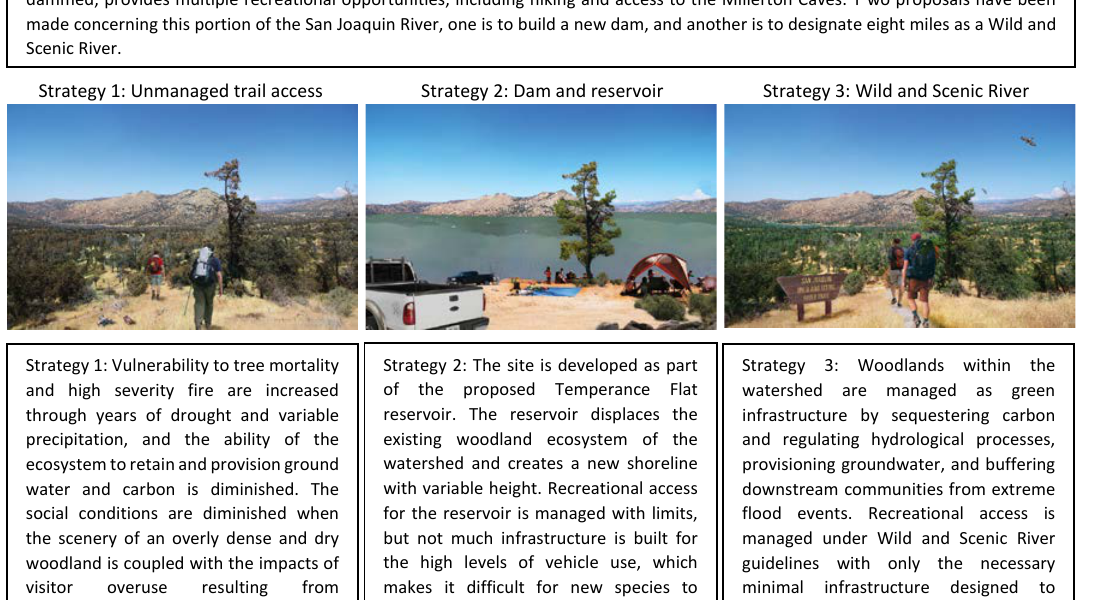
Fig. A1.1 - Site 1: San Joaquin River at Temperance